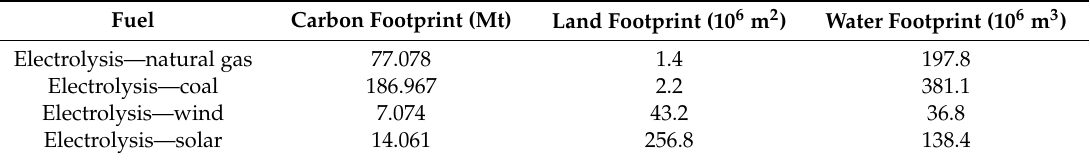
Table A6. Carbon, land and water footprints for scenario 2, the hydrogen scenario.